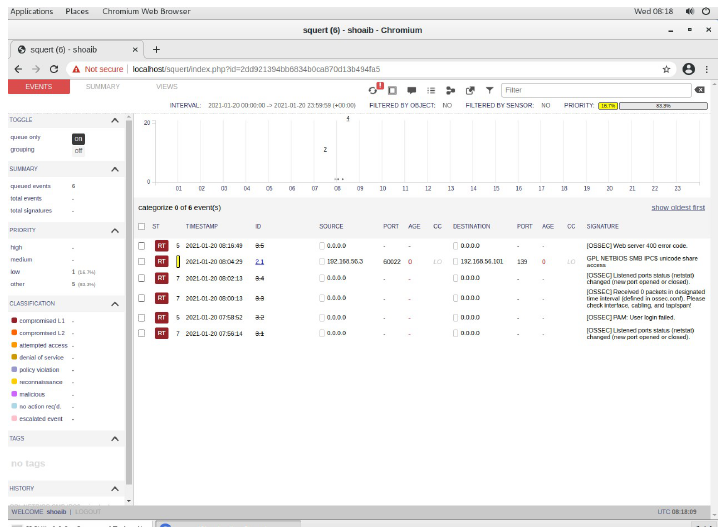
Figure 8. Squert interface shows attacks